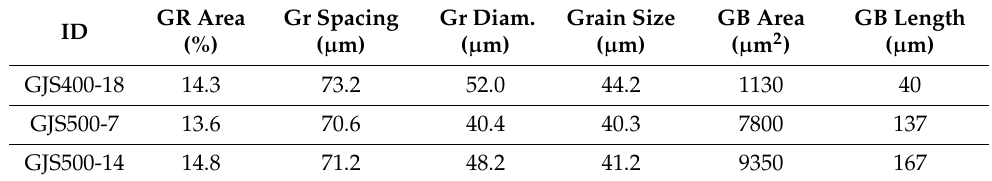
Table 3. Eutectic cell wall area & length. Adapted from [26,31]. GR, Graphite; GB, Grain boundary.